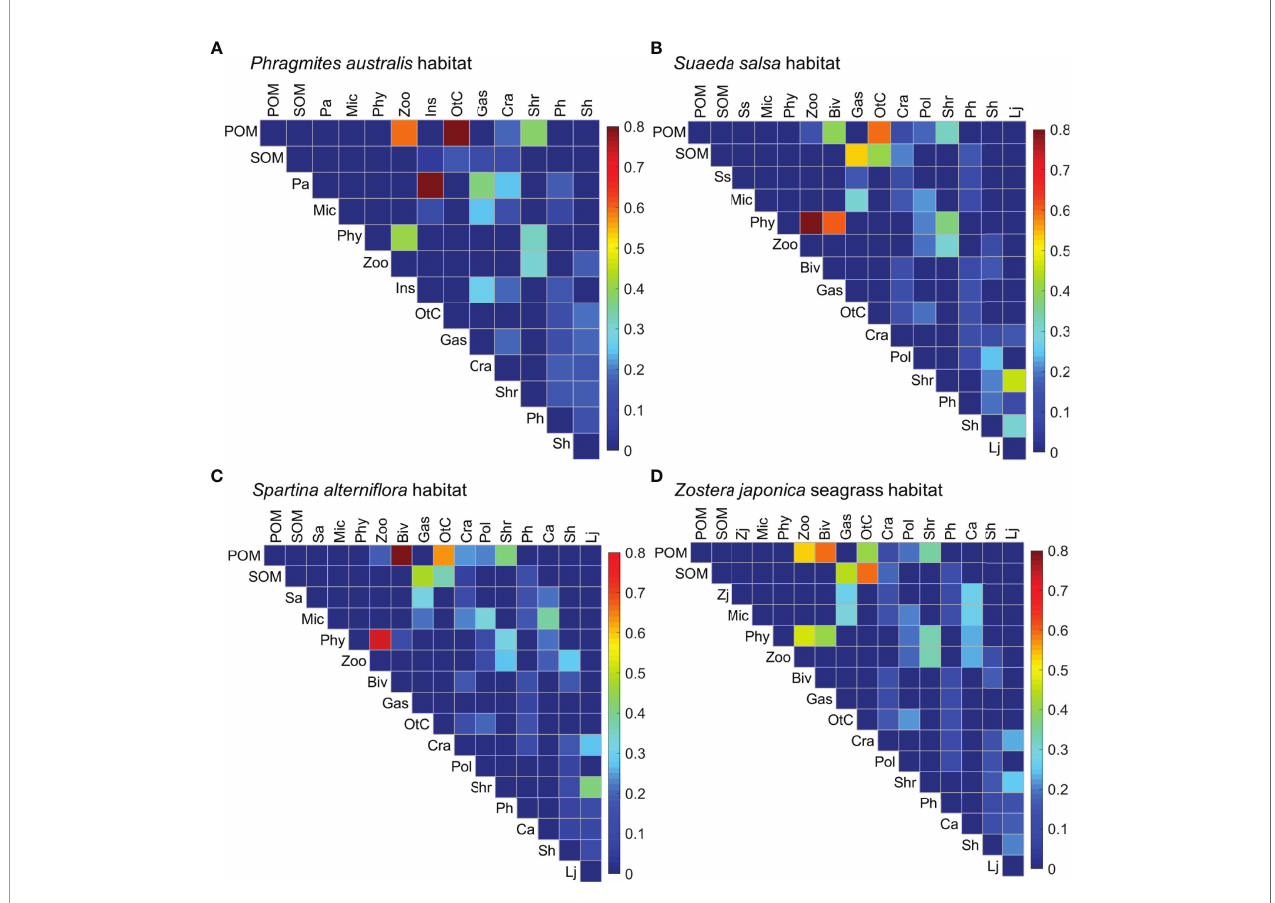
FIGURE 6 | Diet compositions for each trophic group (in the columns) foraging on its prey (in the rows) in the (A) Phragmites australis , (B) Suaeda salsa , (C) Spartina alterni fl ora , and (D) Zostera japonica seagrass habitats along the coastal topographic gradient in the Yellow River Delta wetland. Color intensity is proportional to the magnitude of the diet contributions of the prey to the consumer trophic groups. Abbreviations for the trophic groups: Abbreviations for the trophic groups: Biv, bivalves; Ca, Carassius auratus ; Cra, crabs; Gas, gastropods; Ins, Insects; Lj, Lateolabrax japonicus ; Mic, microphytobenthos; OtC, other crustaceans; Pa, Phragmites australis ; Ph, Planiliza haematocheila ; Phy, phytoplankton; Pol, polychaetes; POM, particulate organic matter; Sa, Spartina alterni fl ora ; Sh, Synechogobius hasta ; Shr, shrimp; SOM, sediment organic matter, Ss, Suaeda salsa ; Zj, Zostera japonica ; Zoo,